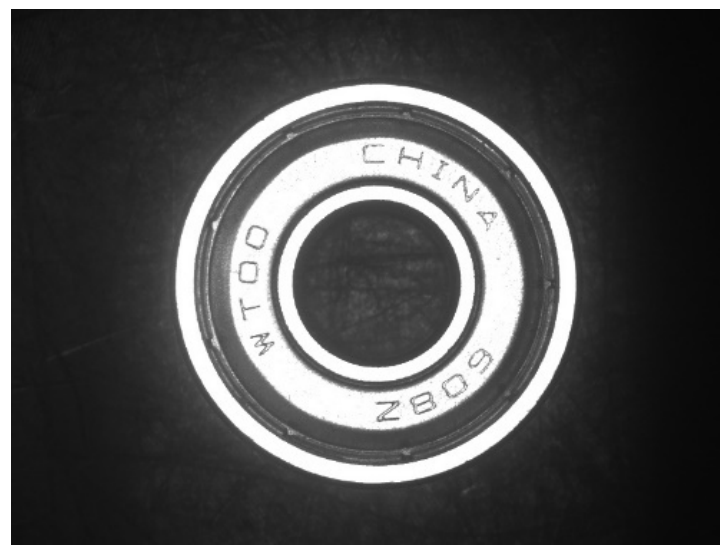
Figure 3. Bearing surface